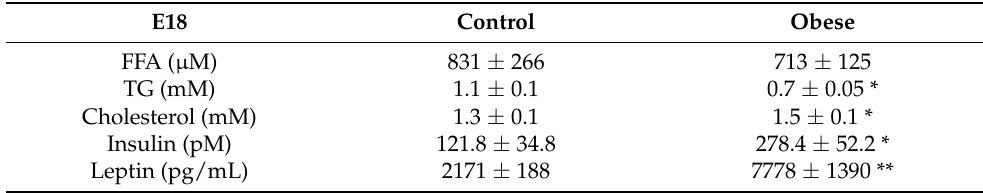
Table 2. The effect of obesity on maternal serum metabolites at E18. Data are expressed as mean ± SEM. The effect of obesity by 2-tailed unpaired t-test and the significant effect of obesity on metabolites are indicated; * p < 0.05, ** p <